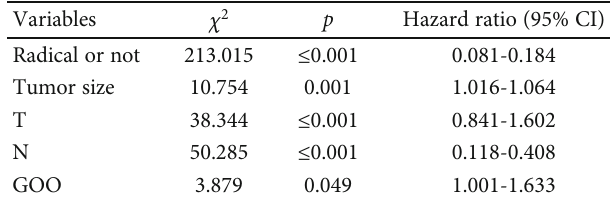
Table 5: Multivariate survival analysis in 1564 gastric cancer patients with and without